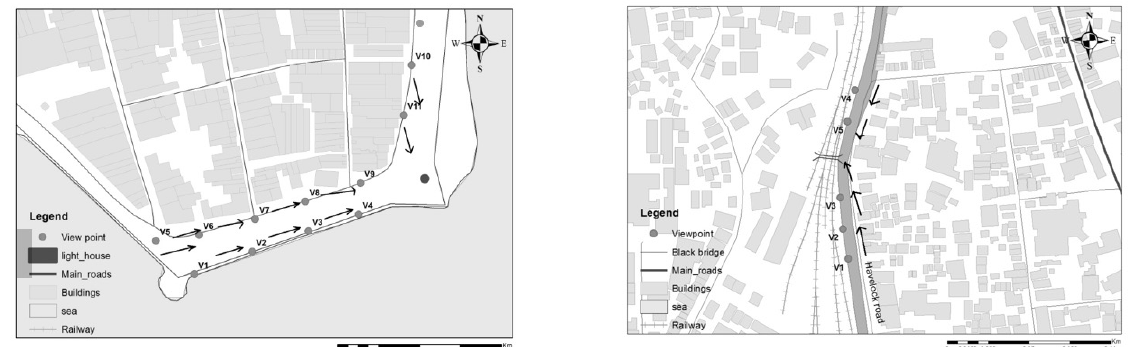
Figure 9. Viewpoints of the landmarks from H5 (Left: lighthouse; right: black